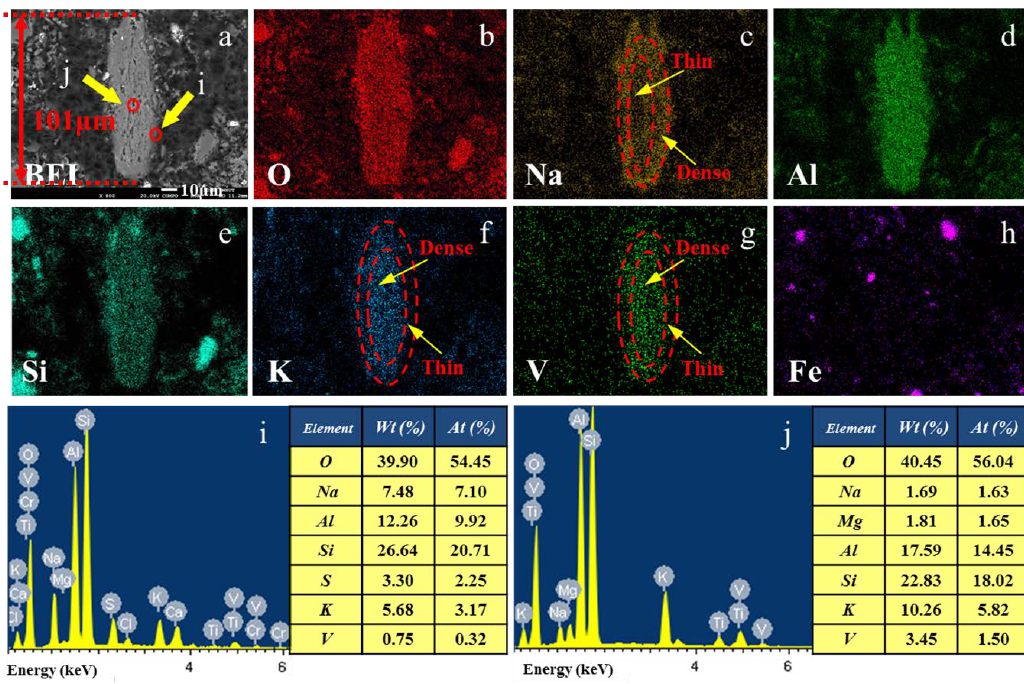
Figure 3. ( a ) BEI of the second type of vanadium-bearing grain in water leaching residue, EDS elemental distribution: ( b ) O, ( c ) Na, ( d ) Al, ( e ) Si, ( f ) K, ( g ) V, ( h ) Fe, and EDS spectra collected from BEI as marked by circle ( i ) at the outer margin and ( j ) at the interior of grain.